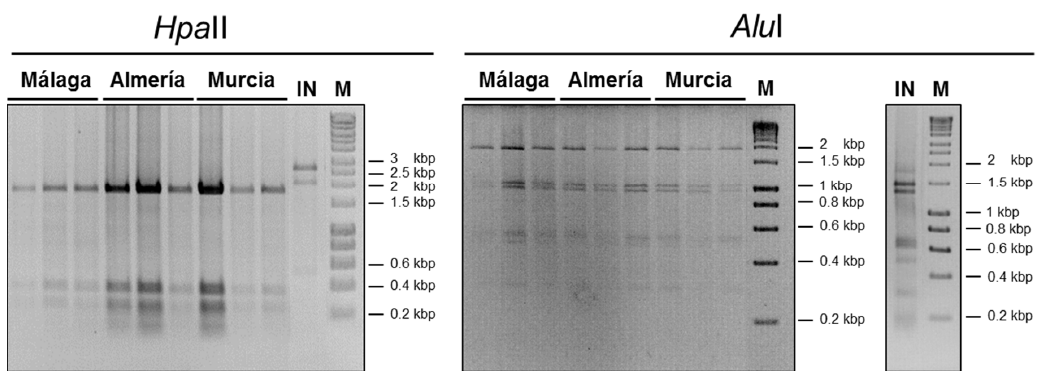
Figure 2. Restriction fragment length polymorphism (RFLP) analysis. Restriction fragment length polymorphism (RFLP) analysis of tomato leaf curl New Delhi virus (ToLCNDV) ‐ infected samples from zucchini squash and melon plants collected in Málaga, Almería and Murcia provinces, performed by digestion of rolling circle amplification (RCA) products with the restriction enzymes Hpa II and Alu I, revealed on a 1.5% agarose gel, with three representative isolates per province shown. Equivalent RFLP analysis for a zucchini squash sample infected with a ToLCNDV from India (ToLCNDV ‐ [India ‐ New Delhi ‐ Severe ‐ 1992], DNA ‐ A and DNA ‐ B GenBank Accession Numbers U15015 and U15017, respectively; labelled as IN) was included; M: 1 ‐ kb DNA ladder marker.